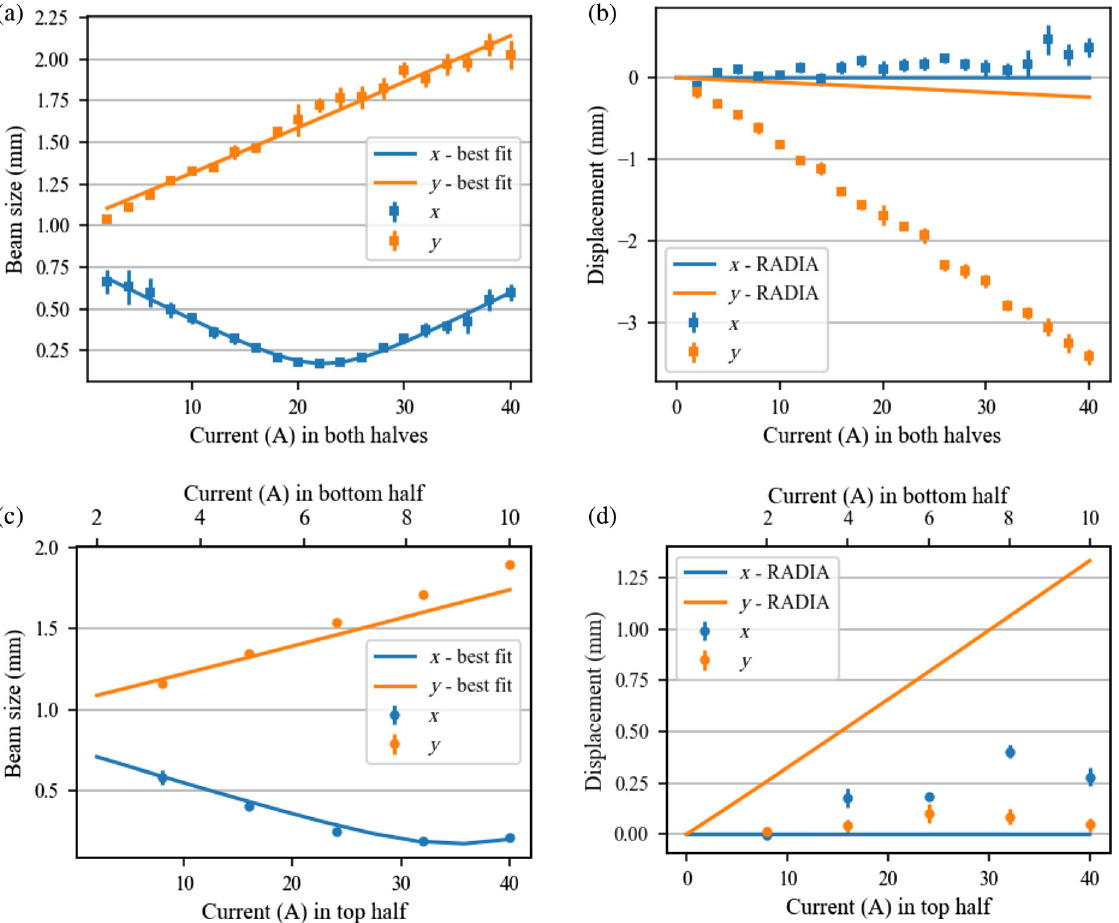
FIG. 9. Beam size and beam displacement as a function of the current magnitude. (a) and (b) Beam size and displacement, respectively, where the current in both halves was the same. (c) and (d) Compensated experiment, where the top half used 4 times as much current as the bottom half to cancel the beam displacement in the y direction. The error bars, many too small to see, denote 1 standard deviation of at least five measurements. The solid lines in (a) and (c) are parabolic least squares fits, and the solid lines in (b) and (d) are RADIA simulations to show the simulated